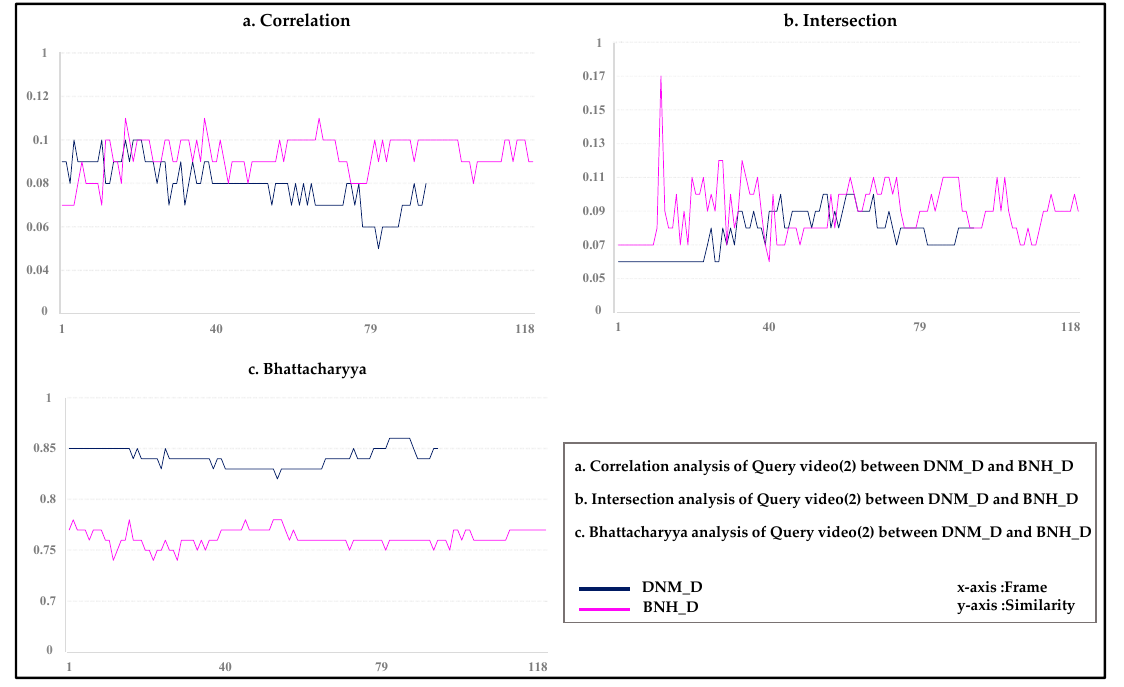
Figure 11. Algorithm similarity comparison between Query video_2 and other videos (scenario 2).